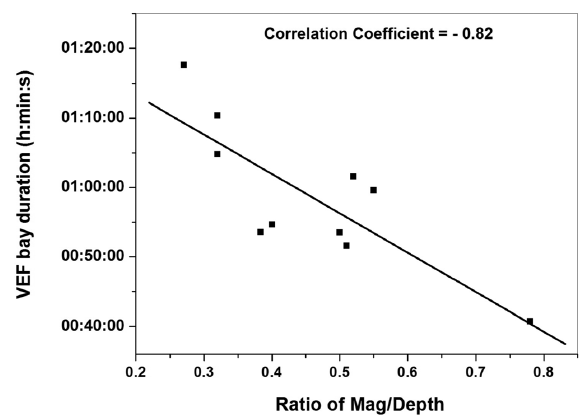
Figure 5. Correlation plot between the ratio of magnitude by depth and the VEF bay